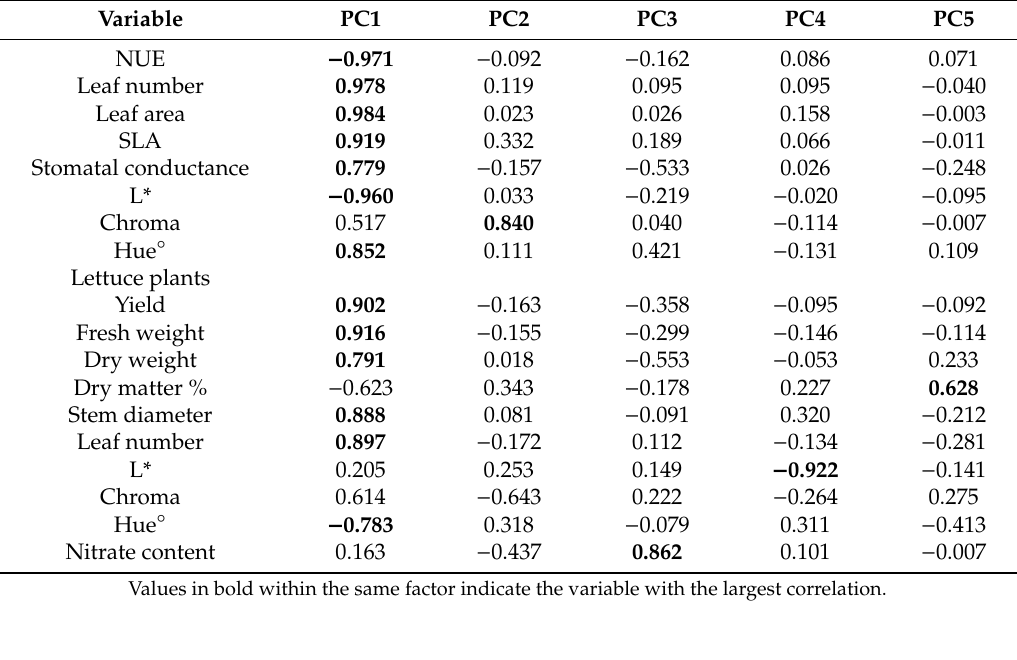
Figure 3. Plot of ( a ) loadings (morphophysiological and quality characteristics of lettuce seedlings and plants) and ( b ) scores (trials) formed by the two principal components from the PCA analysis. – B 0, -B 1, -B 2, and -B 4: uninoculated lettuce fertigated during nursery growth with 0, 1, 2, and 4 g L −1 of fertilizer, respectively; +B 0, +B 1, +B 2, and +B 4: inoculated lettuce fertigated during nursery growth with 0, 1, 2, and 4 g L −1 of fertilizer, respectively.